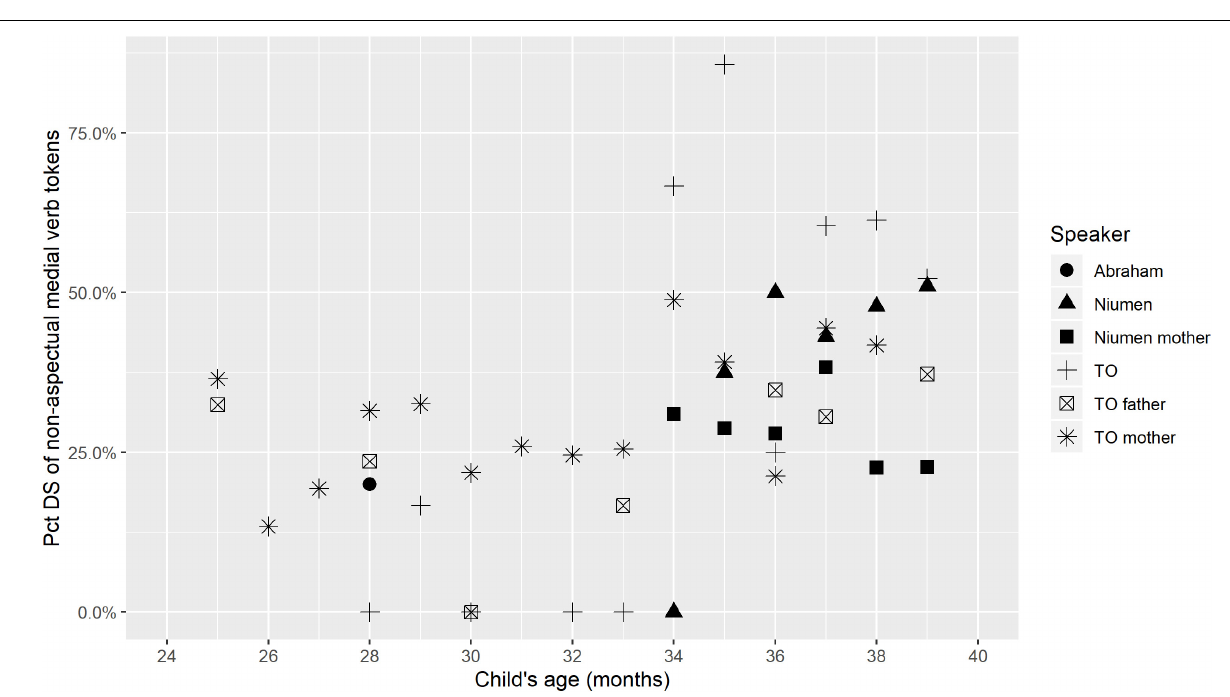
session. Abraham’s first six medial verbs, at 2;4, include one DS- marked medial verb in a root medial clause, but this is one of his utterances that follows a parental